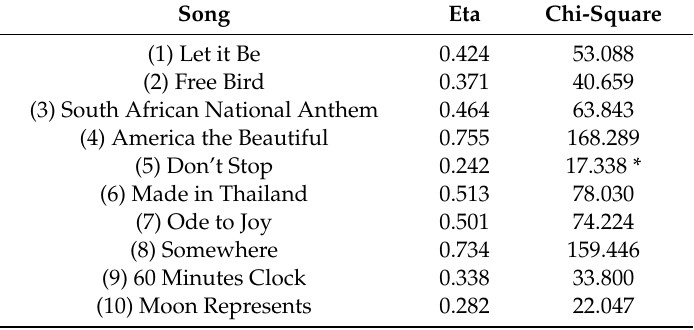
Table 5. Using the Song as the Dependent Variable, Chi-square was calculated across the song Intro, and the data from six nations (United States N = 149), Thailand (N = 34), Germany (N = 36), Tanzania (N = 33), Korea (N = 33), Turkey (N = 10). (Total N = 295). Reported are the Eta values (ANOVA), and Chi-Square statistic. All were significant at the 0.01 level or less, except Don’t Stop, and Chevrona